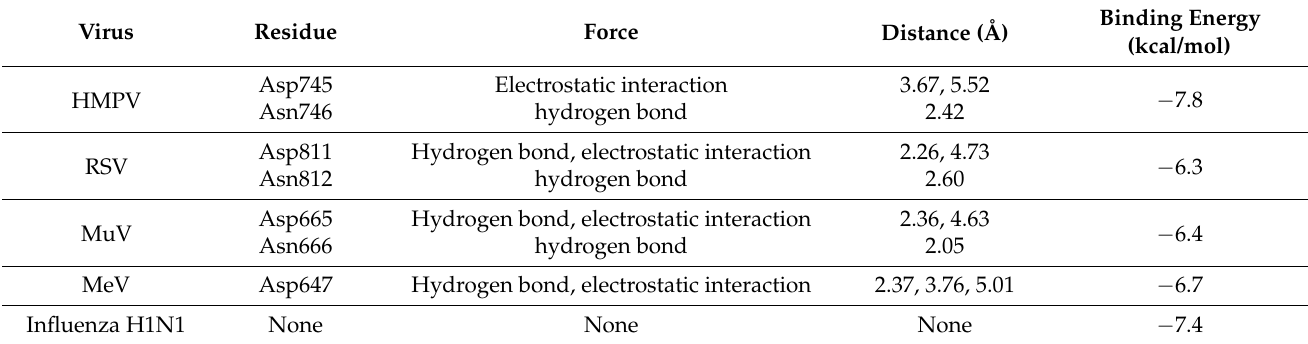
Table 1. Interactions of F-RTP with RdRp active sites and binding energy in various